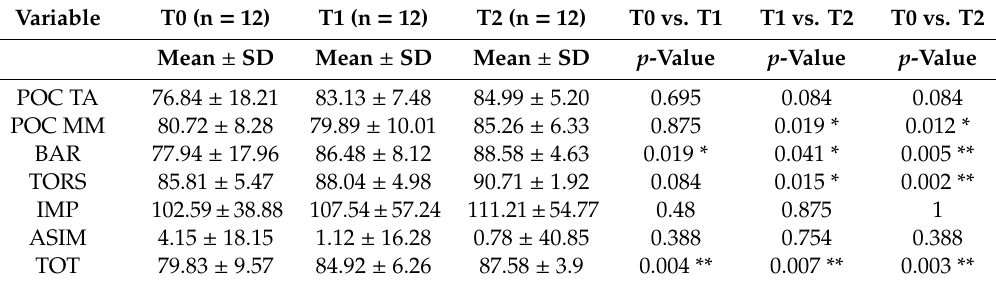
Table 3. Comparing means of each variable at T0, T1 and T2 for digital group (%). Variable T0 (n = 12)